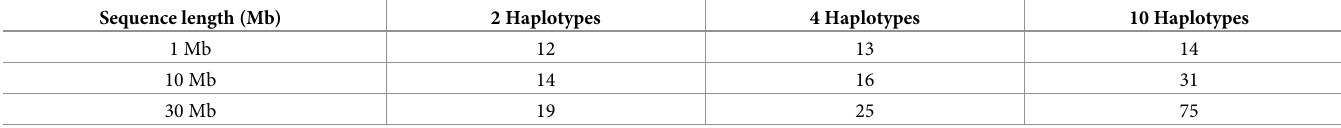
Table 2. Calculation times of eSMC on simulated data under the “saw-tooth” demographic scenario with mutation and recombination rate set to 1.25 × 10 − 8 per generation per bp. Results are in minutes given the sequence length and the number of haplotypes. Sequence length